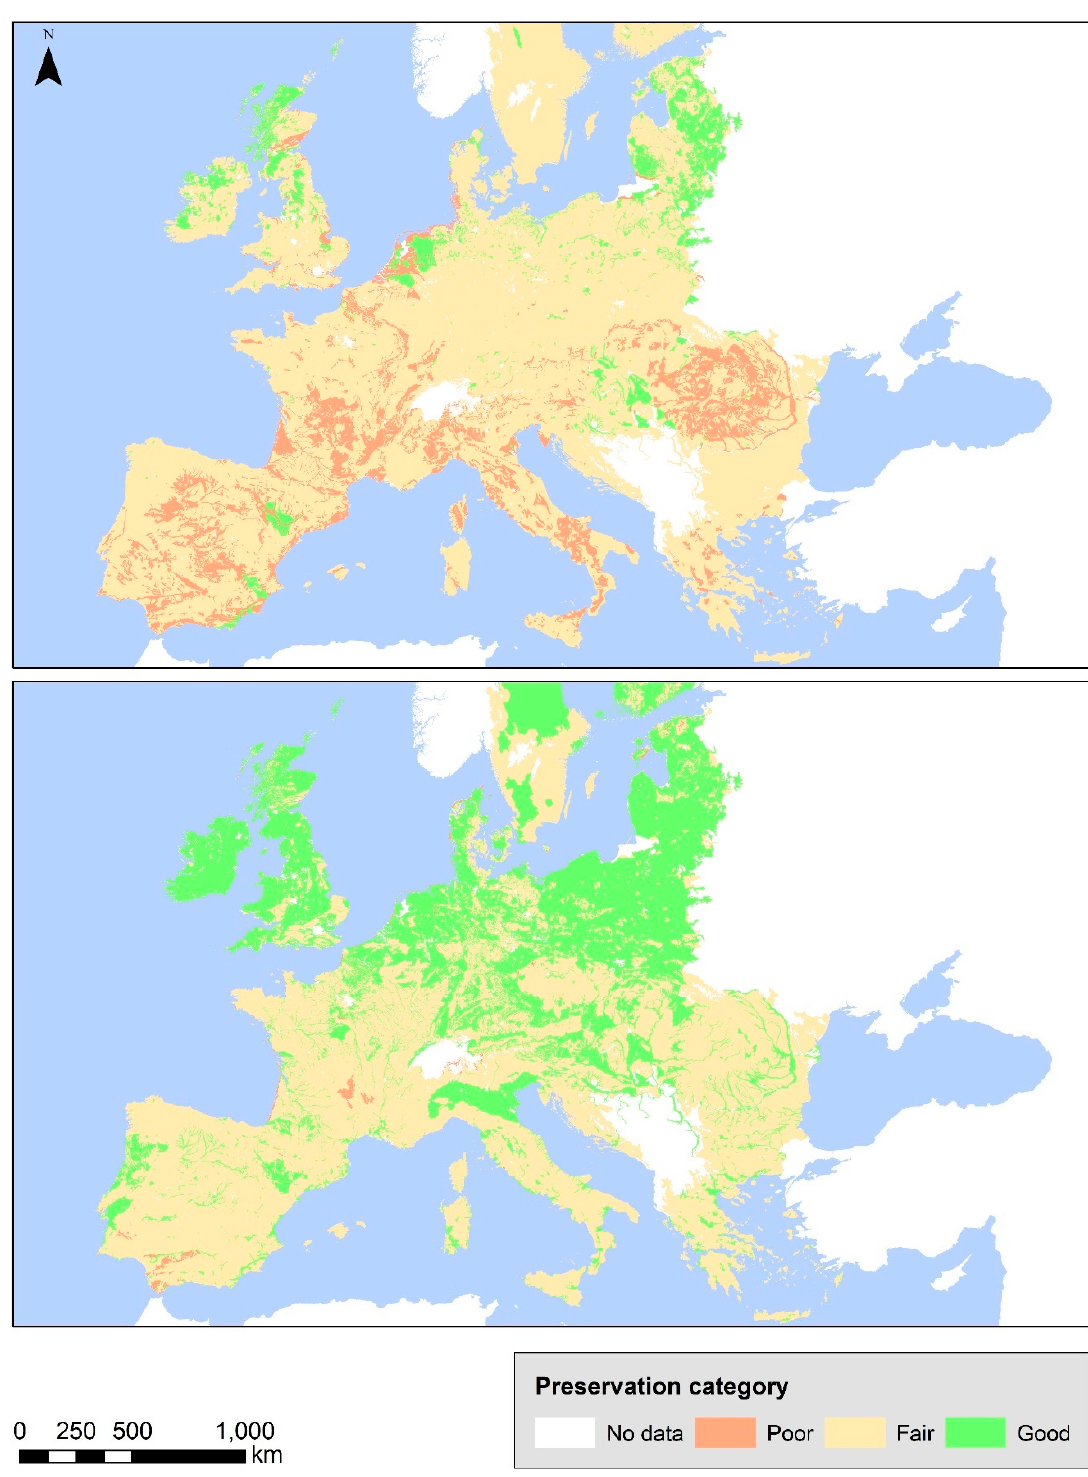
Figure 2. Preservation capacities of buried materials and stratigraphy across Europe for organic materials (top) and stratigraphic evidence (bottom) (data source: References materials (top) and stratigraphic evidence (bottom) (data source: References [32,35]).